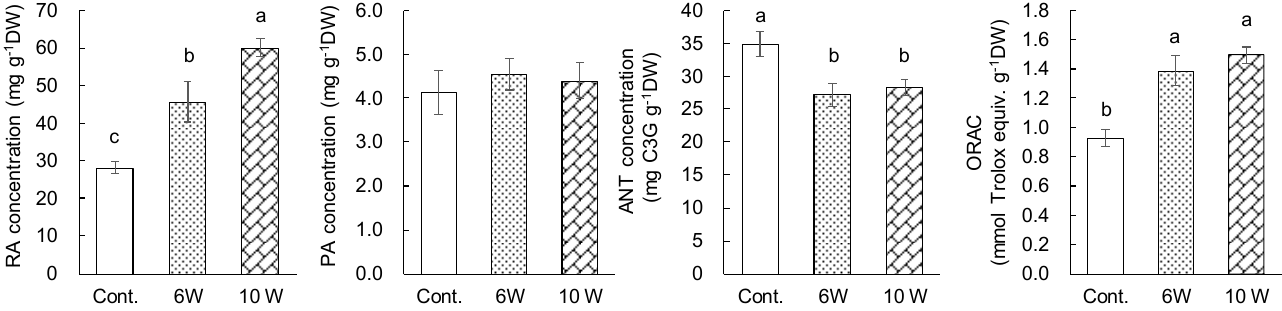
Figure 5. Effect of UV irradiation on rosmarinic acid (RA), perillaldehyde (PA), and anthocyanin (ANT) concentrations and an ORAC value of the 4th leaf of red perilla after 3 d of UV-B treatment (experiment 1). The plants were exposed to UV-B irradiation at 0 (control), 6 (6 W), and 10 W m − 2 (10 W). The vertical bars indicate SE ( n = 4). Different letters indicate significant differences among treatments by the Tukey-Kramer test at p < 0.05.